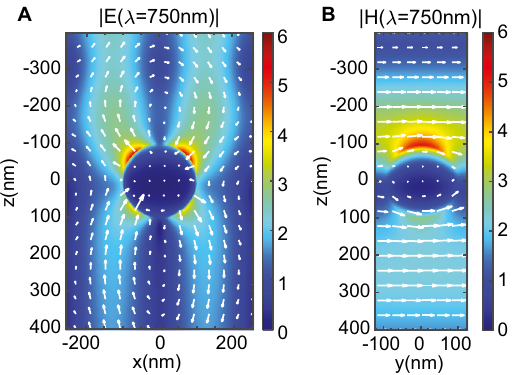
Figure 4: (Color online) (A) Electric | E | and (B) magnetic | H | fi eld amplitudes at the fundamental wavelength. The colormap shows averaged fi eld intensity, and white arrows show the direction of the electric fi eld in a particular time moment. The fi eld amplitude is normalized to the fundamental incident fi